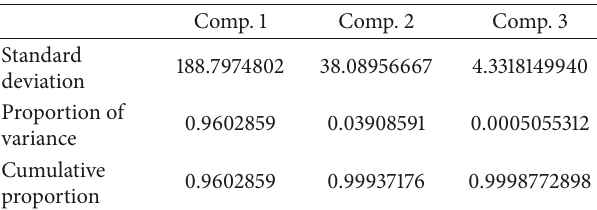
Table 10: Contribution rate of the first three principal components. Comp. 1 Comp. 2 Comp. 3 Standard deviation